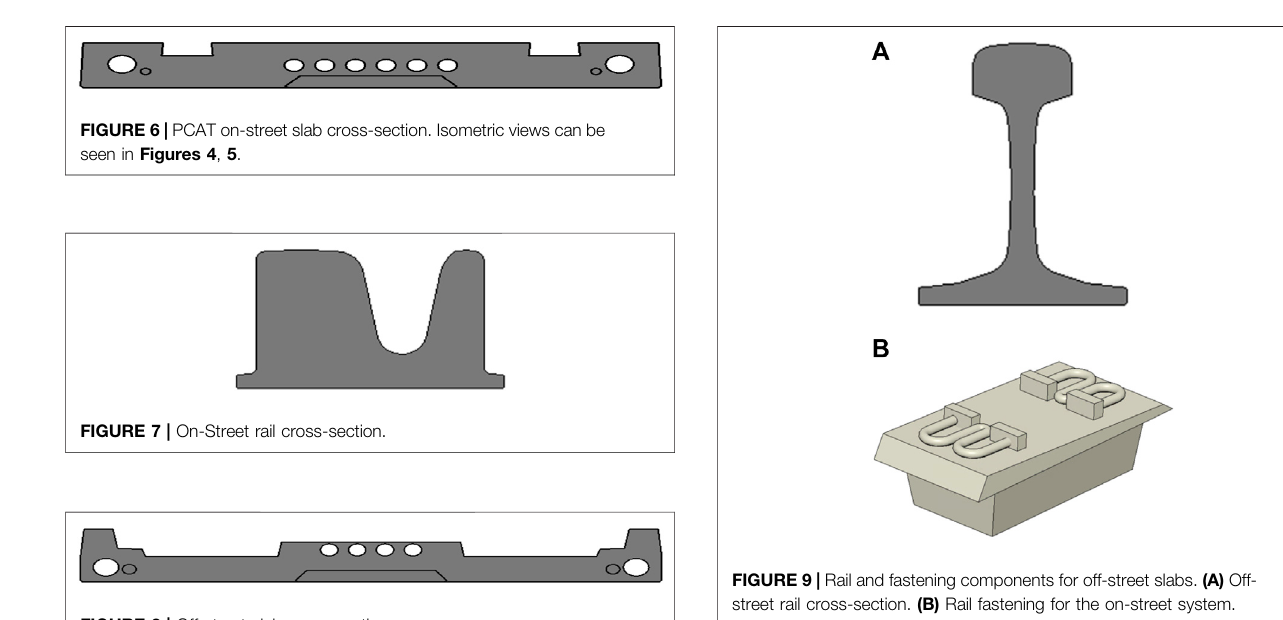
FIGURE 8 | Off-street slab